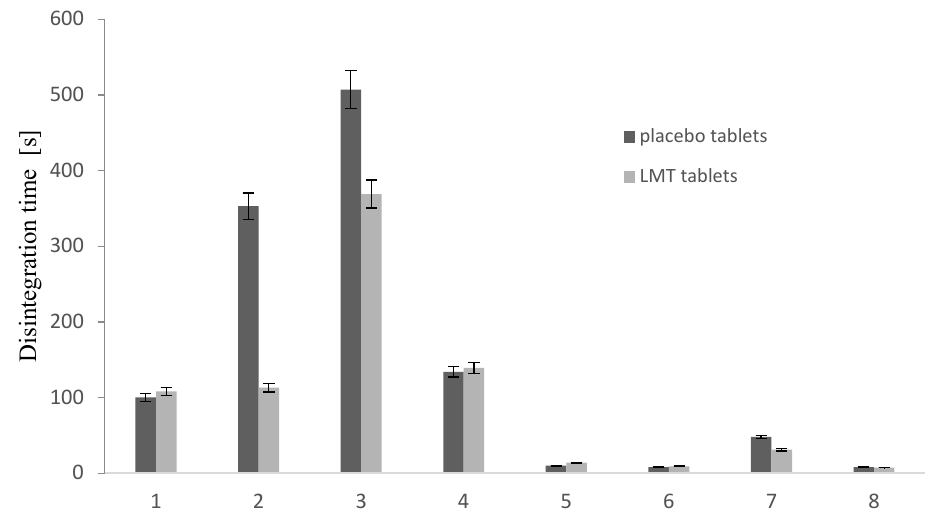
Figure 6. Disintegration of placebo tablet formulations and LMT tablets.